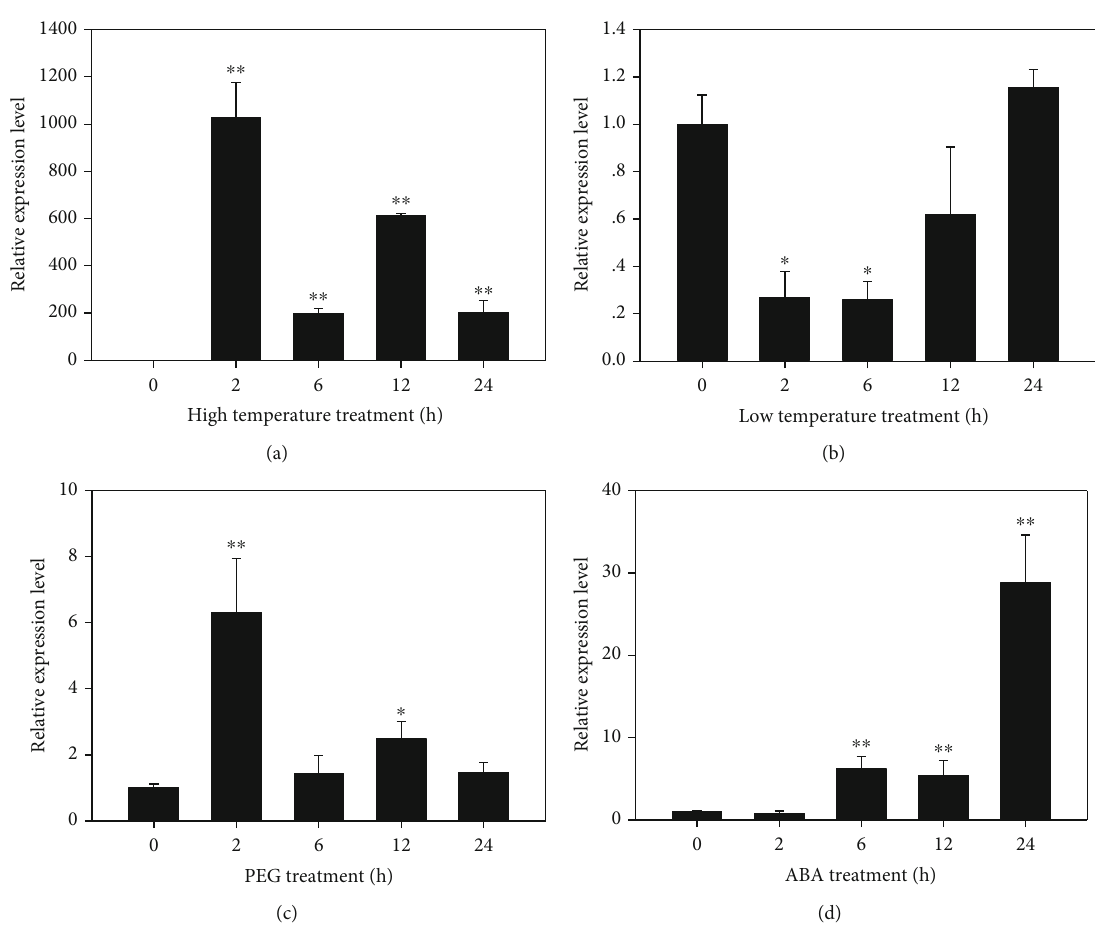
Figure 3: Expression analyses of KvHSP26 in response to abiotic stress and ABA treatments. Four-week-old K. virginica plants were treated at 42 ° C or 4 ° C or with 15% PEG6000 or 100 μ M ABA for 0, 2, 6, 12, and 24 hours. (a, b) Relative expression levels of KvHSP26 in response to high (42 ° C) and low (4 ° C) temperature treatments. (c, d) Relative expression levels of KvHSP26 in response to 15% PEG6000 and 100 μ M ABA treatments. The results were the means of three biological replicates. The error bars were the standard deviations of three replicates. ∗ and ∗∗ stand for the signi fi cant di ff erences at p < 0 : 05 and p < 0 : 01 ,